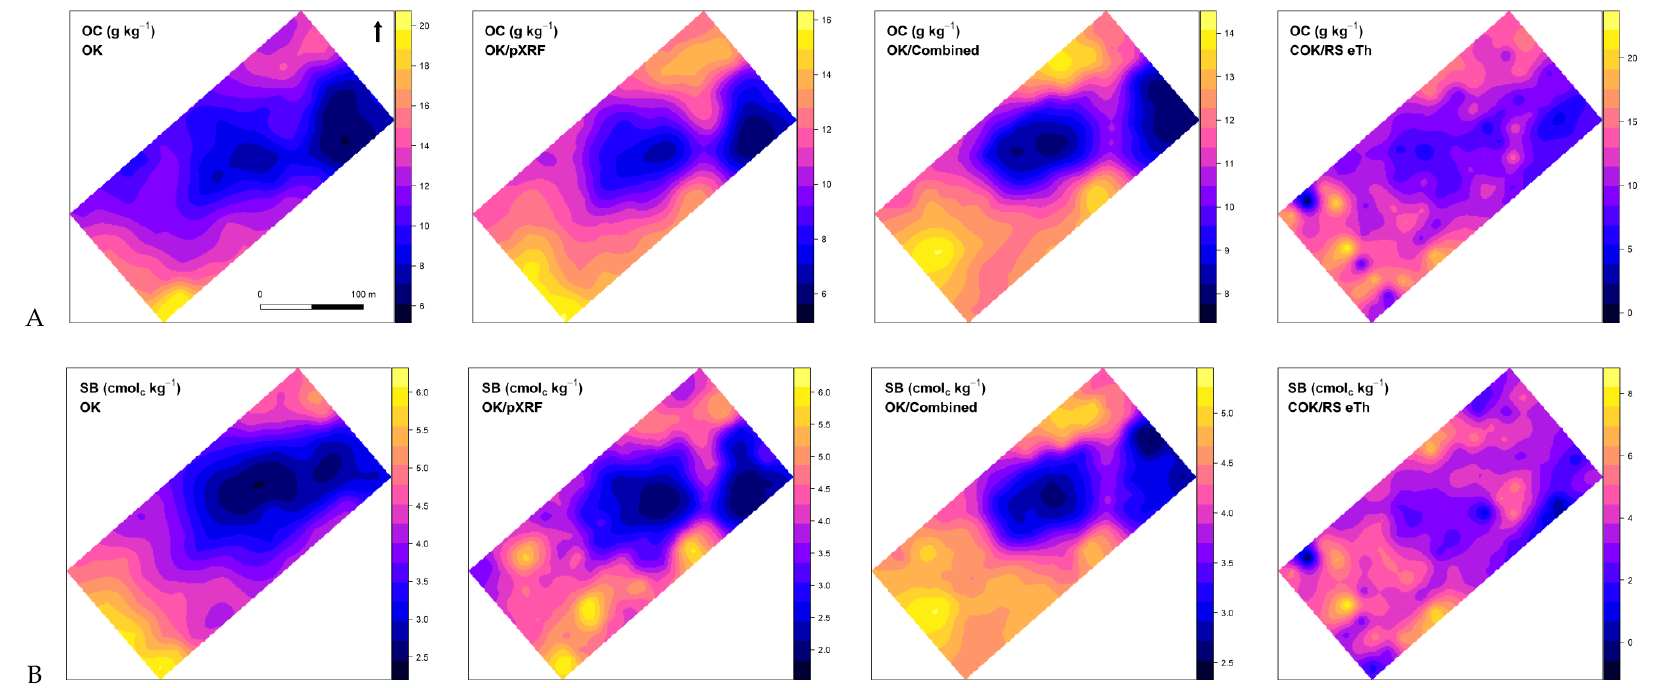
Figure 3. Empirical and fitted spherical variograms of soil ( A ) organic carbon content (OC; g kg − 1 ), ( B ) sum of bases (SB; cmol c kg − 1 ), ( C ) cation exchange capacity (CEC; cmol c kg − 1 ), ( D ) clay content (g kg − 1 ), ( E ) volumetric moisture ( θ ; %), and ( F ) bulk density (BD; g cm − 3 ). OK, ordinary kriging; COK, ordinary cokriging; eTh, equivalent Th content; ECa, apparent electrical conductivity; pXRF, DP-6000 portable X-ray fluorescence spectrometer; RS, RS-230 BGO gamma-ray spectrometer; KT, KT-10 S/c MSa/ECa sensor.